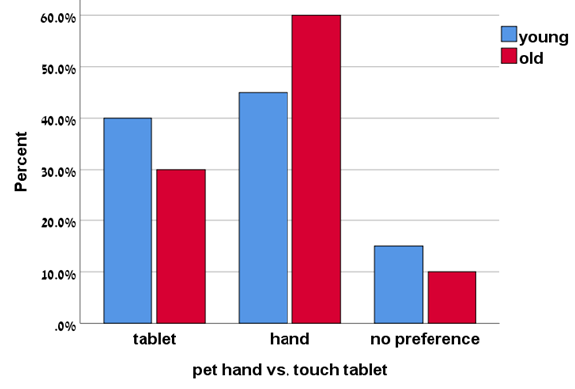
Figure 5: Summary of the results of Experiment 2: preference of petting the robot’s hand or touching its tablet in order to indicate completion of the task. The results are presented as percentage of each